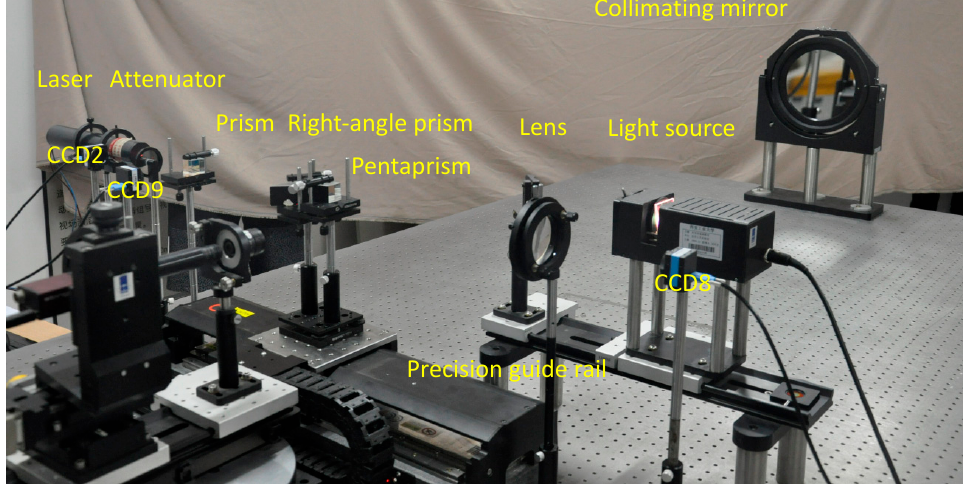
Figure 3. Experiment device diagram.